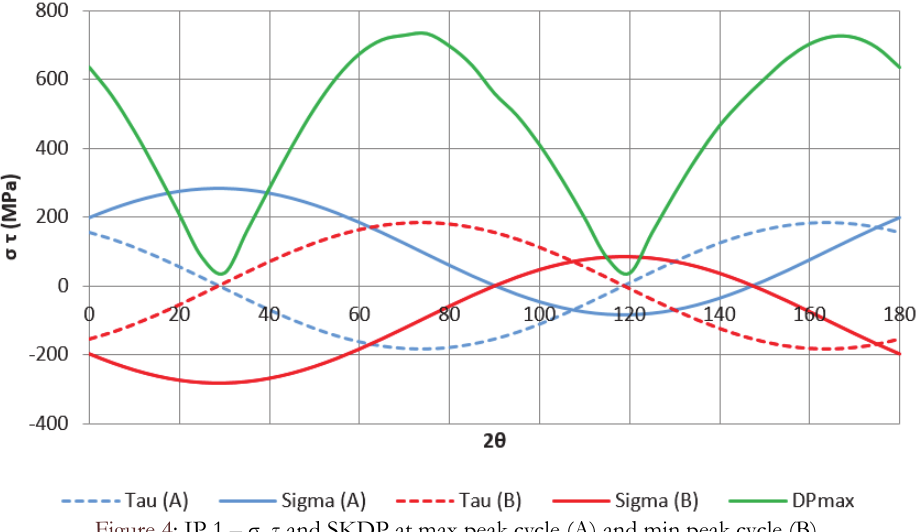
Figure 4: IP 1 – σ , τ and SKDP at max peak cycle (A) and min peak cycle (B)